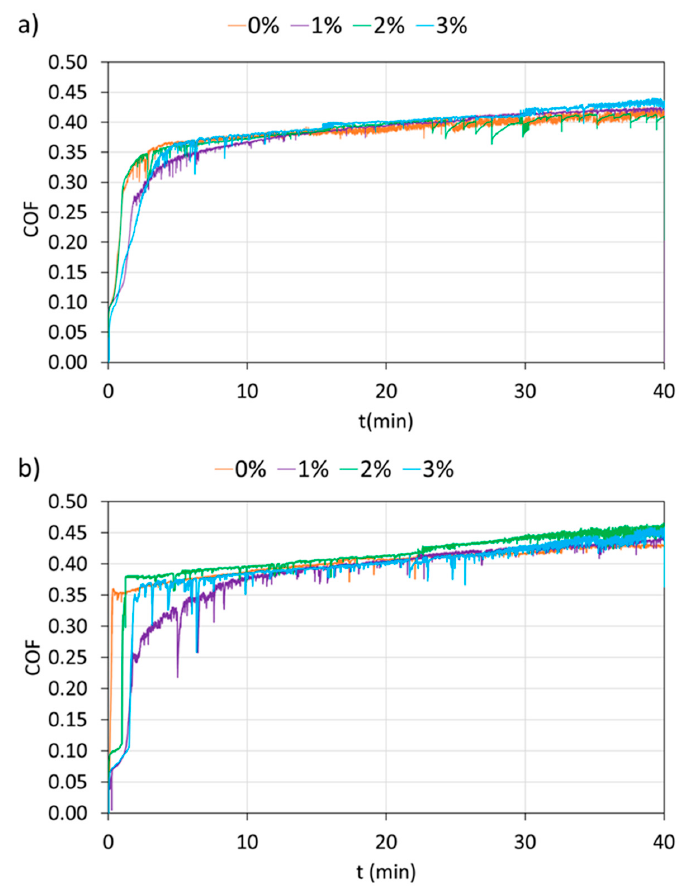
Figure 7. COF evolution of all organic coatings at ( a ) 0 h and ( b ) 500 h of exposure.